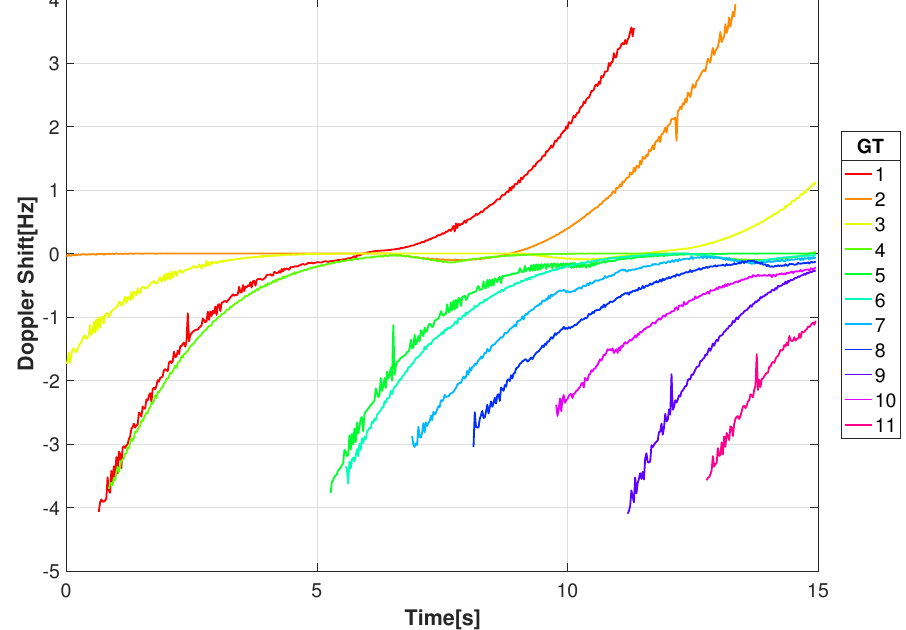
Figure 7. Doppler Shift at 1 GHz carrier frequency for the moving ground targets as measured from location of the video sensor for the given video sequence.